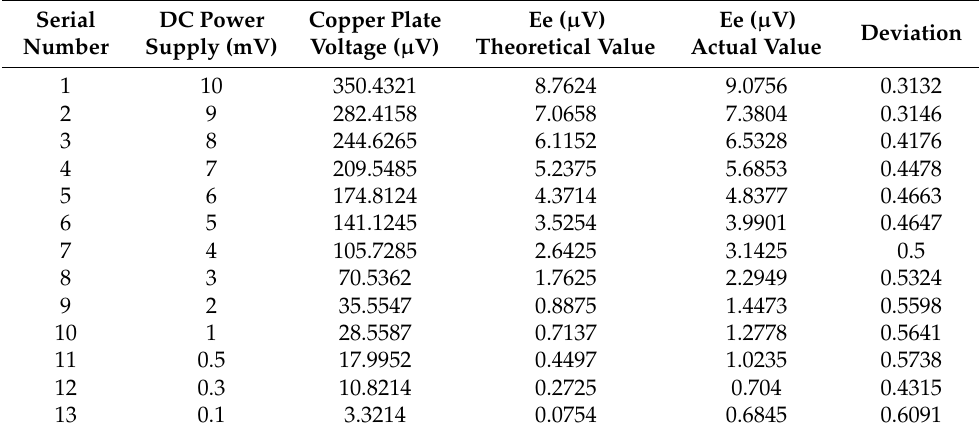
Table 2. AC electric field test